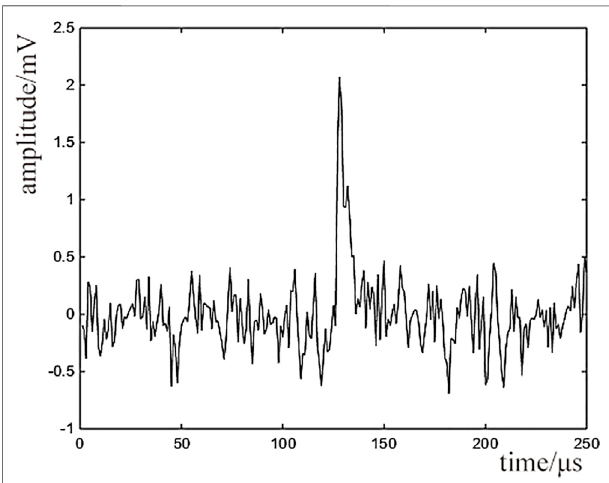
FIGURE8| Nuclearpulsesignaloutputbytheneutrondetectionsystem built in the laboratory.